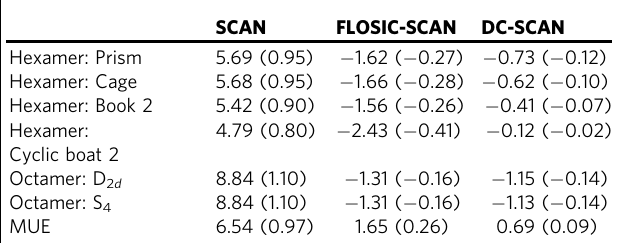
Table 1 Errors (in kcal/mol) in binding energies relative to the CCSD(T)-F12b values of ref. 86 calculated for representative isomers of the water hexamer and octamer using SCAN, FLOSIC-SCAN (from ref. 50 ) and DC-SCAN. The values in parentheses correspond to the errors per molecule. The last row reports the corresponding MUEs and MUEs per